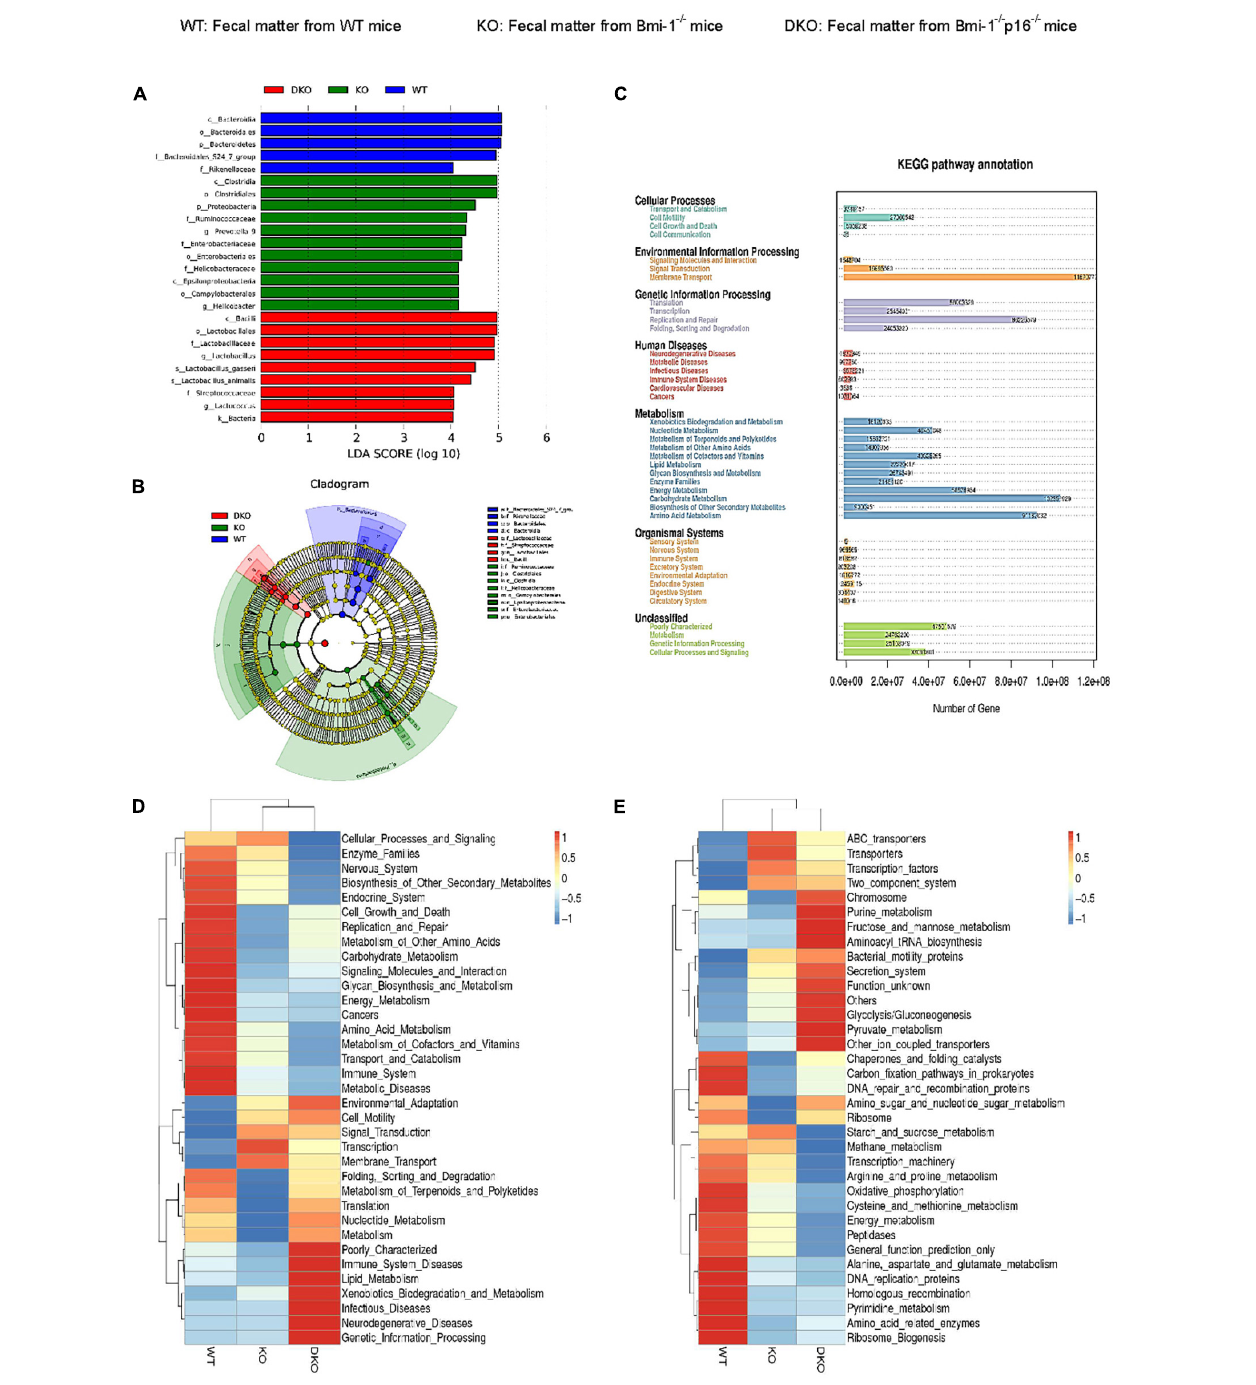
FIGURE 8 | P16 deletion improved intestinal microbial function ameliorated in Bmi-1 − / − mice. High-throughput sequencing of V4 region amplicon of 16S rRNA from intestinal microbiota was conducted using the fecal of 7-week-old WT, Bmi-1 − / − , and Bmi-1 − / − p16 − / − mice. (A) LEfSe results represented significant differences in bacterial taxa enriched in the WT, KO, and DKO groups. Only taxa with LDA > 4.0 are shown. (B) The evolutionary branch map obtained from LEfSe sequence of WT, Bmi-1 − / − , and Bmi-1 − / − p16 − / − mice. Radiation circle represents the classification level from phylum to genus. Yellow circle indicates no difference; red, green, and blue represent species with significant difference in each group. (C) Functional enrichment analysis of KEGG pathway. (D,E) Heat map of functional analysis based on the average abundance of KEGG pathway in the three groups, n = 8. The heat map is colored based on row Z scores. The mice with the highest and lowest functional enrichment are in red and blue,